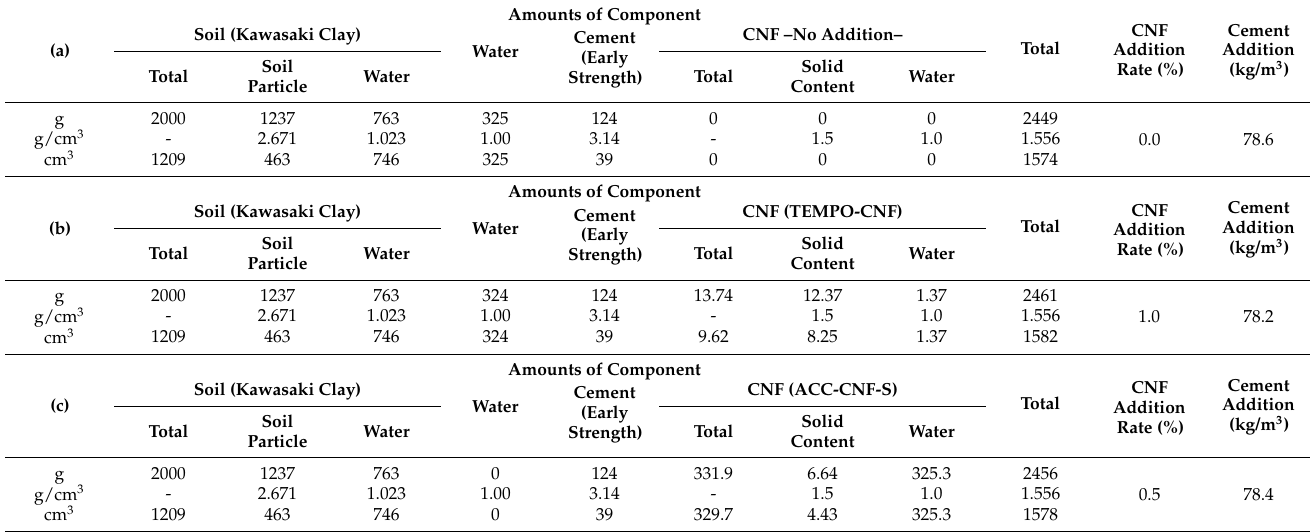
Table 5. Mix proportion of cement, CNF, water, and soil in Method 2 for evaluating permeability: ( a ) Treated soil without CNF; ( b ) Treated soil with TEMPO-CNF (Powder); ( c ) Treated soil with ACC-CNF-S